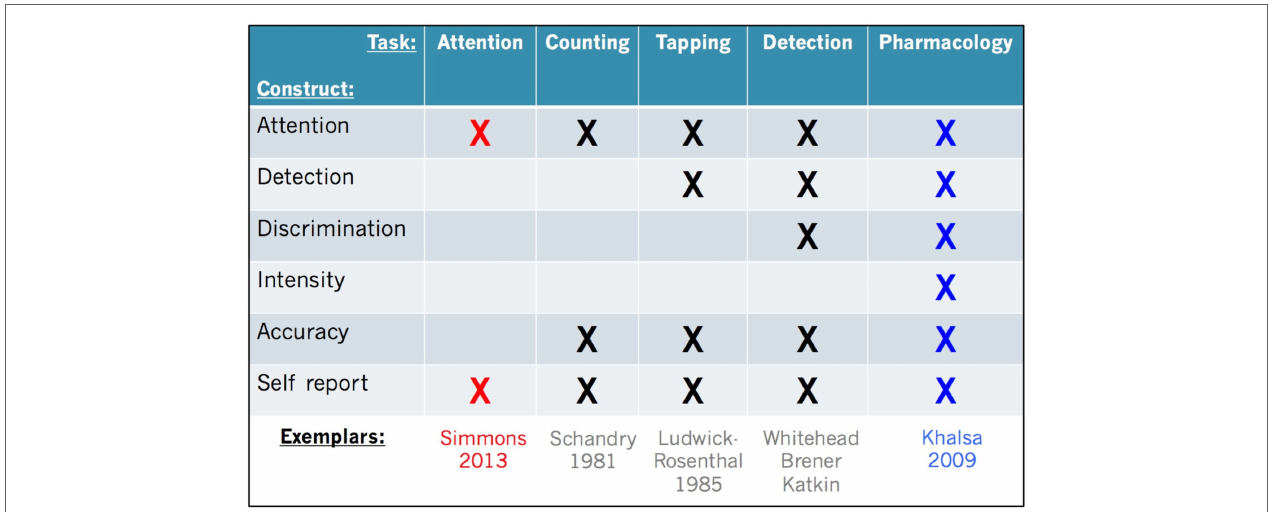
FiGURe 2 | Facets of cardiac interoception . Representative constructs, tasks, and exemplar studies from the literature. We recommend that future studies include multiple tasks evaluating the facets of cardiac interoception from converging perspectives (e.g., red and blue highlighted tasks). An analogous approach is recommended for other interoceptive sensory modalities (see text for